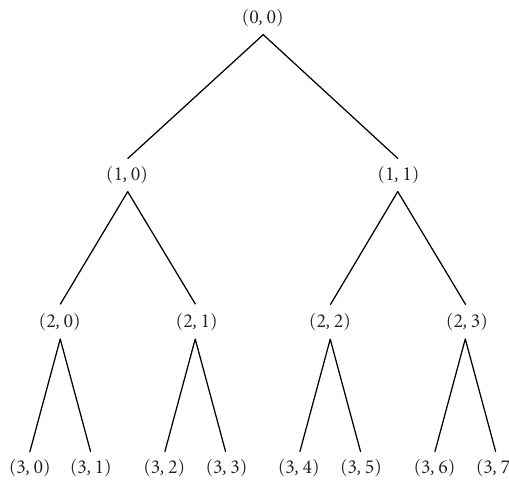
Figure 3.13. Best-level decomposition